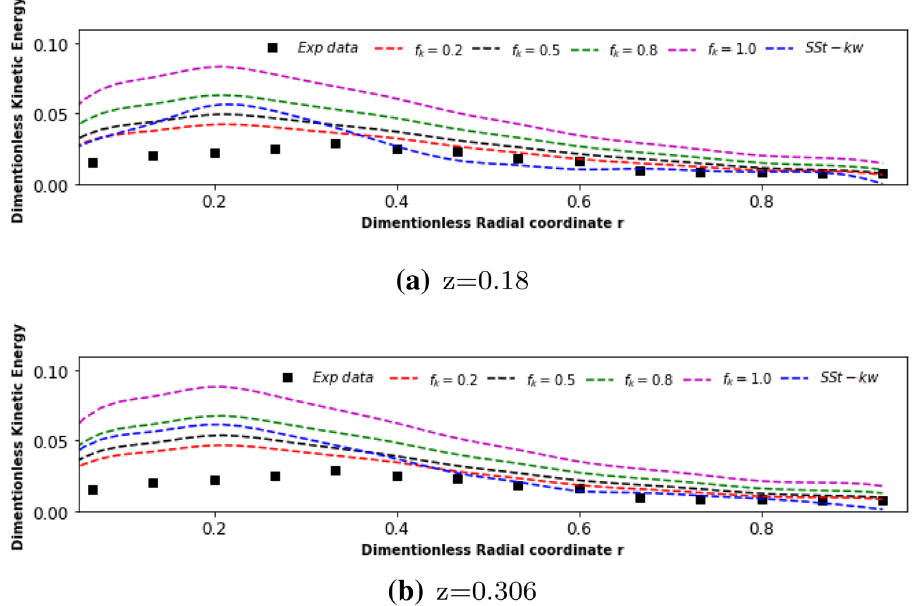
Fig. 10 Turbulent kinetic energy profiles below the impeller at different z-location for f k = 0.2 ( - - - ), f k = 0.5 ( - - - ), = 0.8 ( - - - ), f = 1.0 ( - -- ) of f k k PANS k u − 𝜖 u model, SST k − 𝜔 model ( - - - ) and experimental data ( ▪